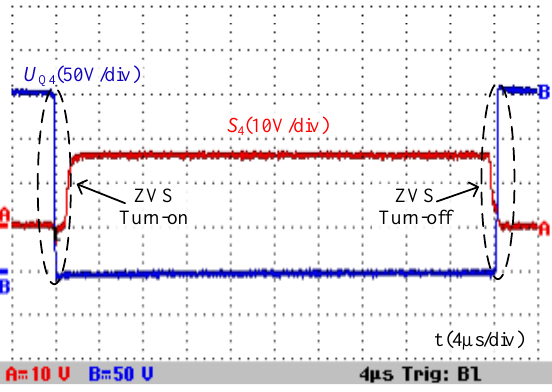
Q1 and U Q2 ; ( b ) U Q3 and U Q5 . Energies 2018 , 11 , x FOR PEER REVIEW